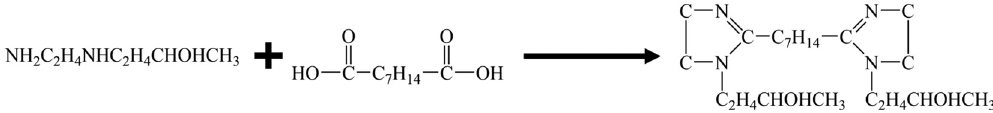
Figure 1: Synthesis of nano - SiO 2 @bisimidazoline